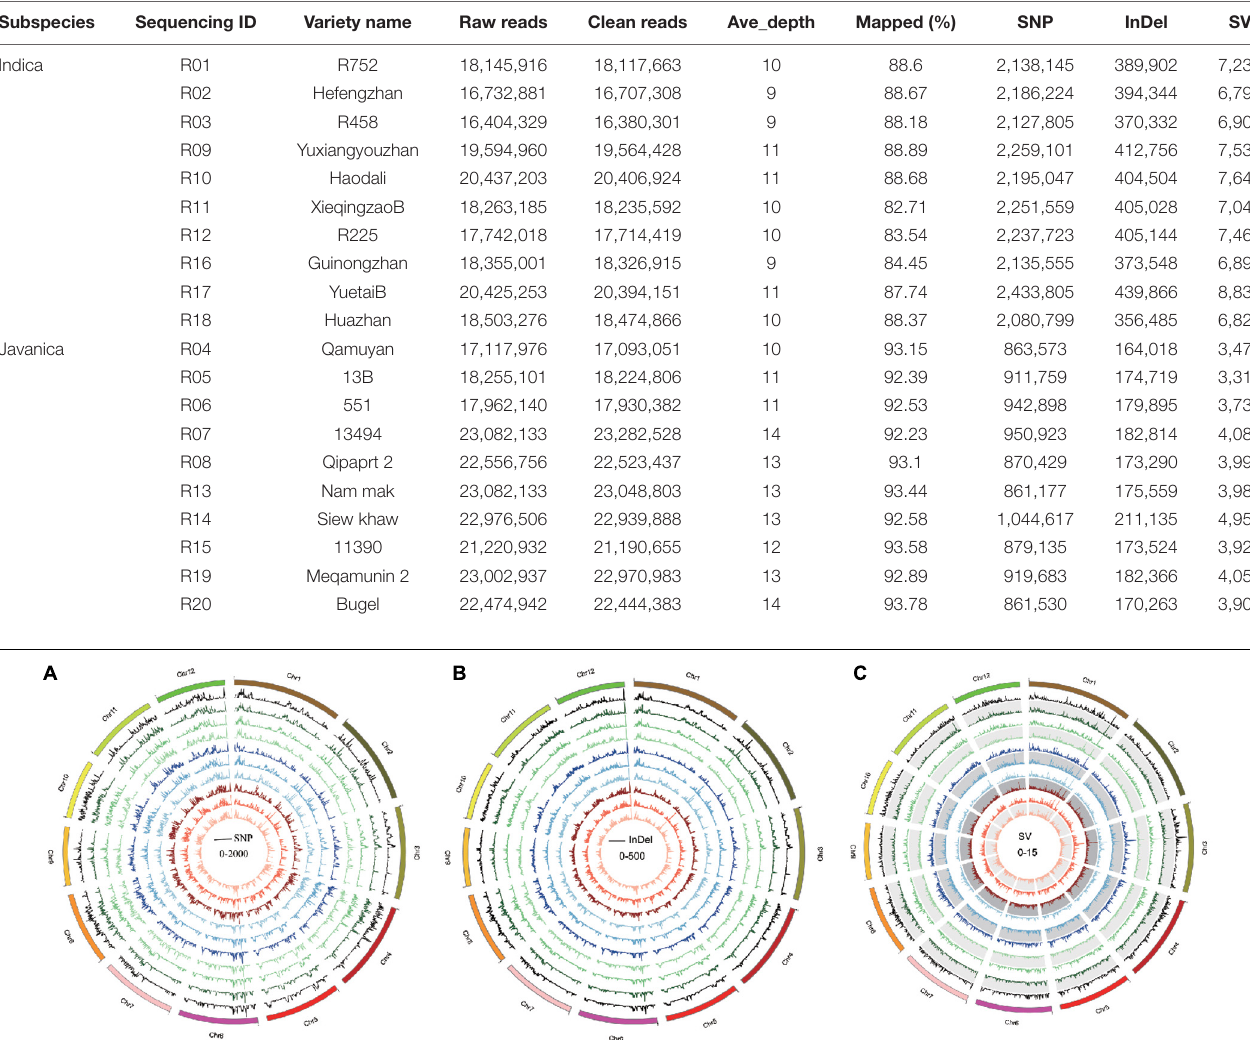
TABLE 1 | The resequencing information of 20 rice varieties.